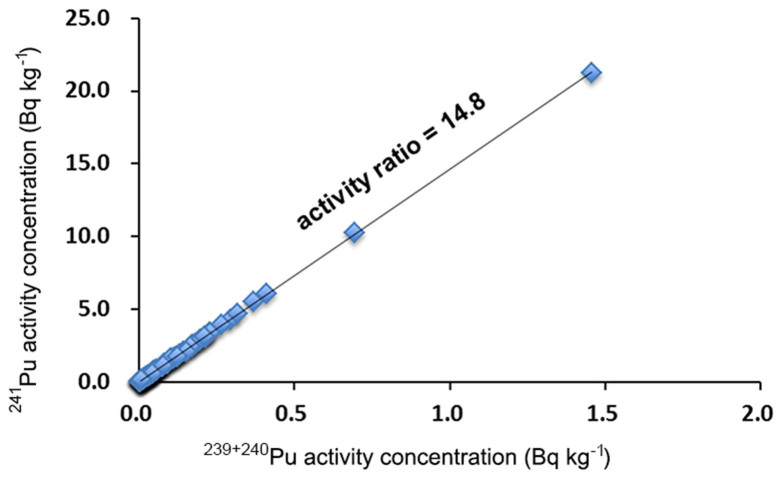
Estimated activity ratios of 241Pu/239+240Pu in school grounds soil samples collected in central-eastern Japan during the period of peak global fallout in 1964.